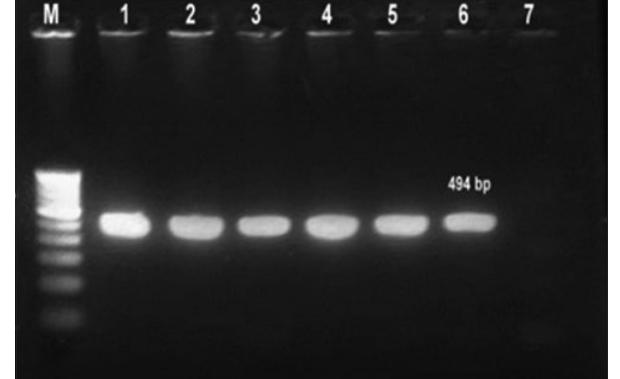
Figure-2: Multiplex polymerase chain reaction for Campylobacter genus and species identification. Lane M: 100 bp ladder, Lanes 1, 2, 3, 5, 6, 7: Campylobacter coli , Lane 4: Campylobacter jejuni .